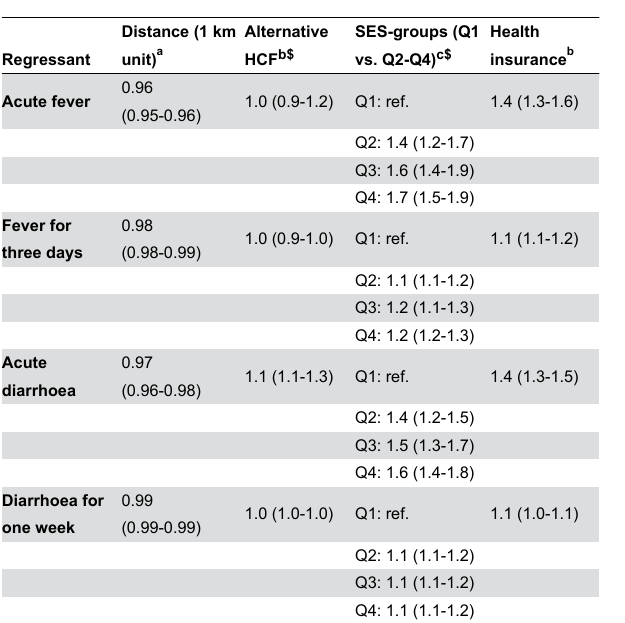
Table 4. Poisson regression models of the relationship between hospital attendance and explanatory variables for the different disease symptoms, Asante Akim North District, Ghana,